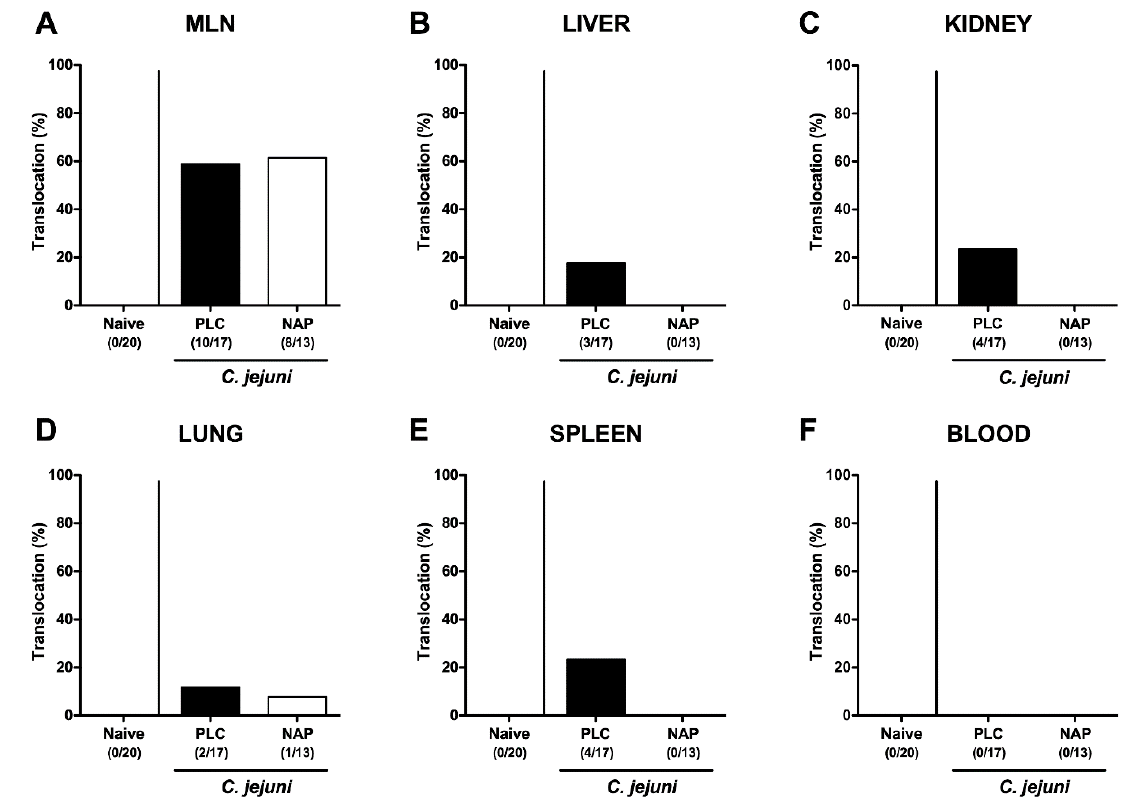
Figure 8. Bacterial translocation following NAP treatment of C. jejuni infected secondary abiotic IL10 − / − mice. On day (d) 0 and d1 secondary abiotic IL10 − / − mice were perorally infected with C. jejuni strain 81-176 by gavage and treated intraperitoneally with either synthetic NAP (open bars) or placebo (PLC; closed bars) from d2 until d5. On d6 post-infection, the abundance of C. jejuni was assessed in ex vivo biopsies derived from ( A ) mesenteric lymph nodes (MLN), ( B ) liver, ( C ) kidney, ( D ) lung, ( E ) spleen, and ( F ) cardiac blood by culture. Naive mice served as negative controls. The cumulative relative translocation rate of viable pathogens into the respective compartment out of four independent experiments (in %) as well as the numbers of culture-positive mice out of the total number of animals (in parentheses) are indicated.